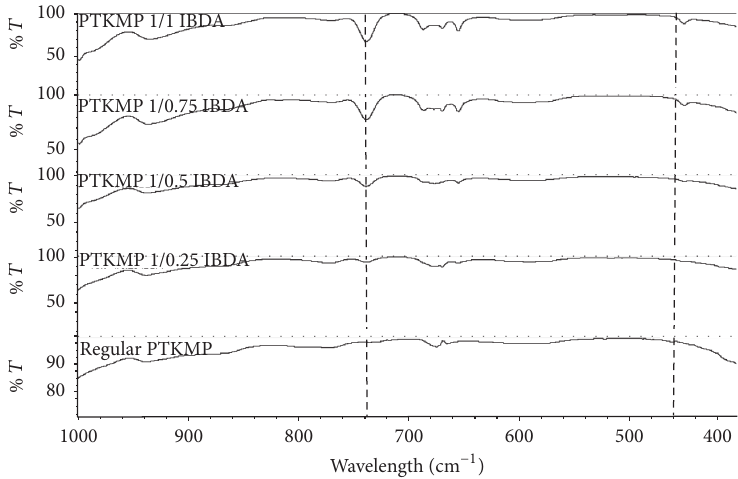
Figure 1: FTIR spectra of PTKMP with varying concentrations of IBDA.